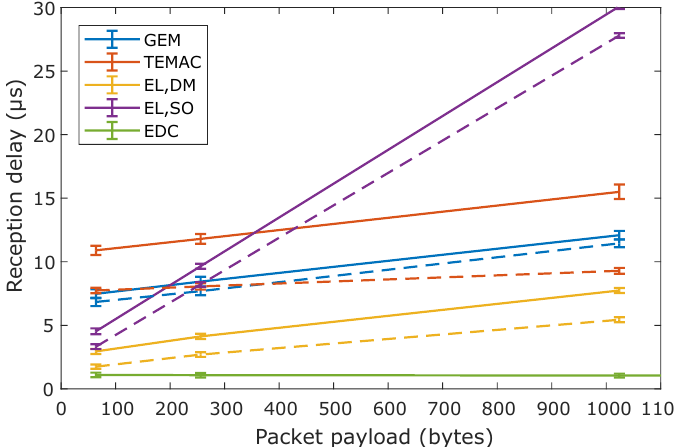
Figure 5. Incoming packet delay (essentially the MAC delay): (i) time from the reception of a packet to transferring the respective data to its final memory destination (dashed lines); and (ii) time to enter a UDP callback function (full lines). The EDC line (lower line) corresponds to the results achieved with the EDC hardware accelerator described in Section